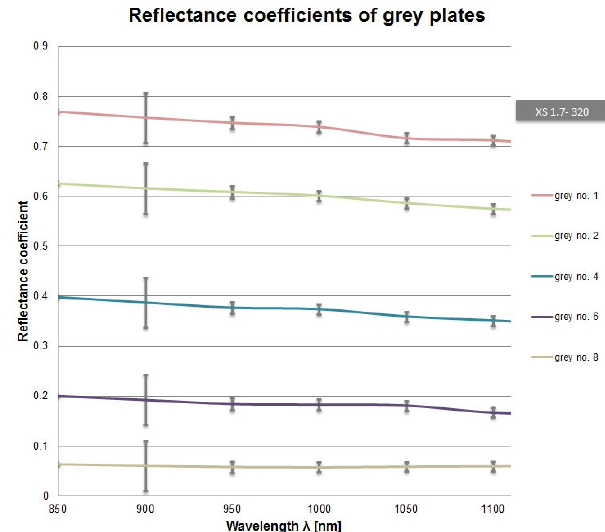
Figure 4. Reflectance coefficients of chosen grey plates with measurement errors (XEVA XS 1.7- 320 video